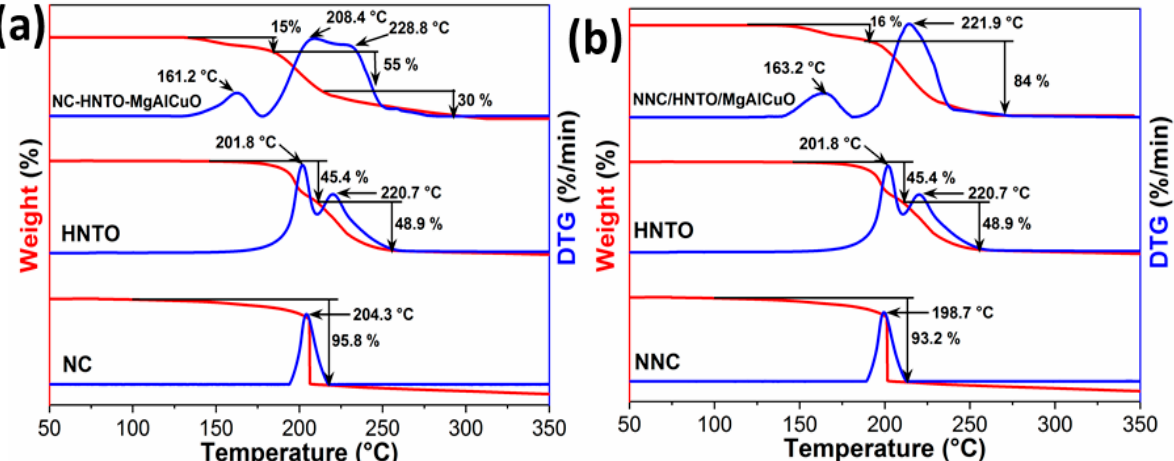
Figure 3. TGA/DTG thermograms of the (a) NC/HNTO/MgAl-CuO and (b) NNC/HNTO/MgAl- CuO composites and their raw compounds at β = 10 °C/min.